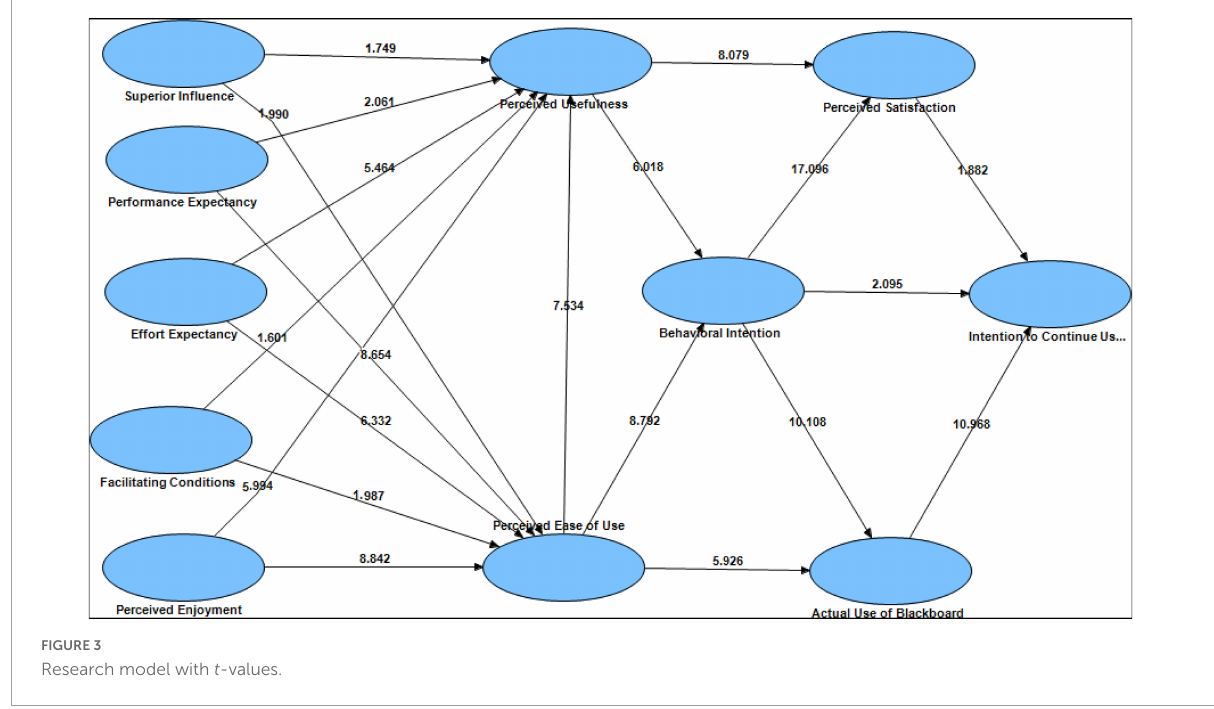
FIGURE3 Research model with t -values.